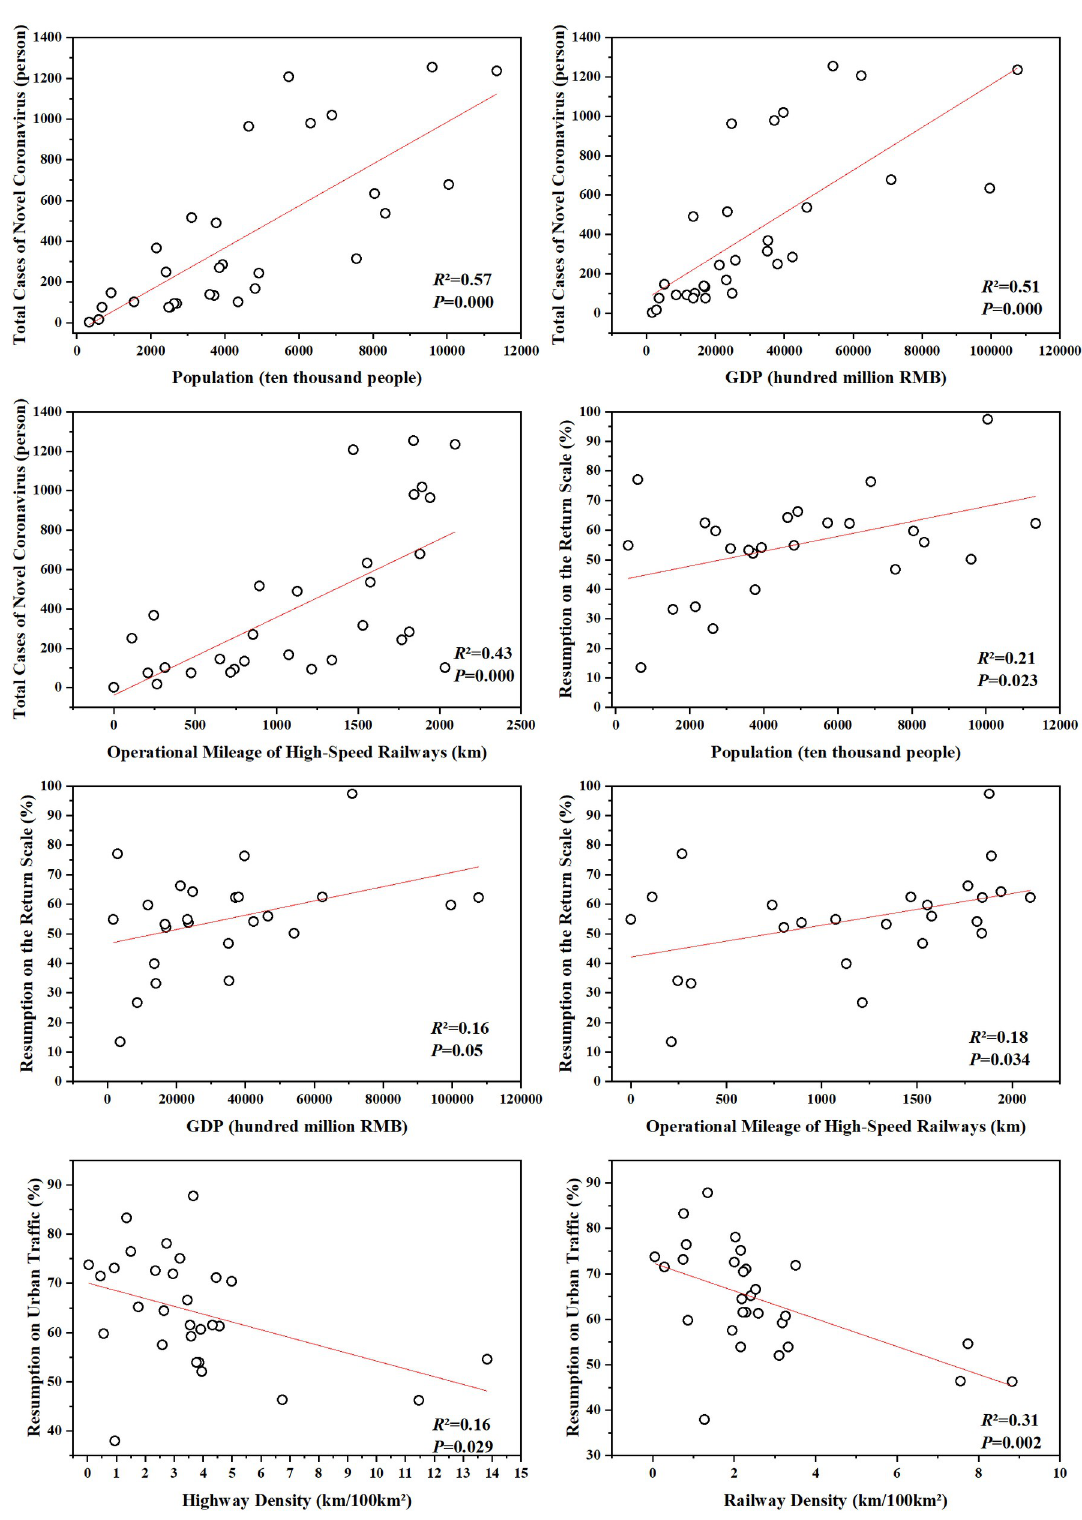
Fig 8. Correlation between the number of cases, resumption of return scale, resumption of urban traffic intensity and socioeconomic indicators.